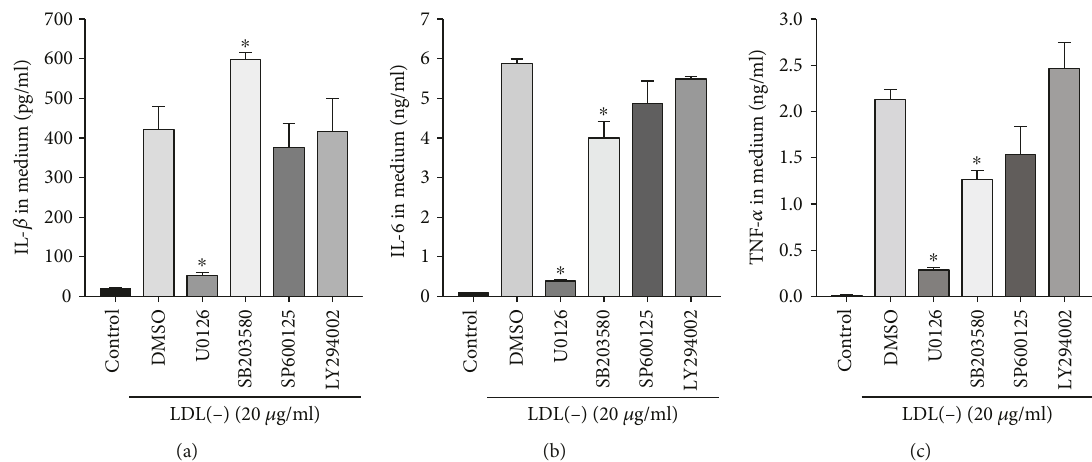
Figure 7: E ff ects of MAPK inhibitors on the LDL(-)-induced IL-1 β , IL-6, and TNF- α in macrophages. Cells were preincubated with DMSO, U0126 (10 μ M), SB203580 (10 μ M), SP600125 (15 μ M), or LY294002 (10 μ M) for 1h, then treated with LDL(-) for 24 h. Levels of IL-1 β (a), IL-6 (b), and TNF- α (c) in the medium were determined by ELISA. Values are the mean ± SD of three independent experiments. ∗ p < 0 05 , compared to DMSO-treated